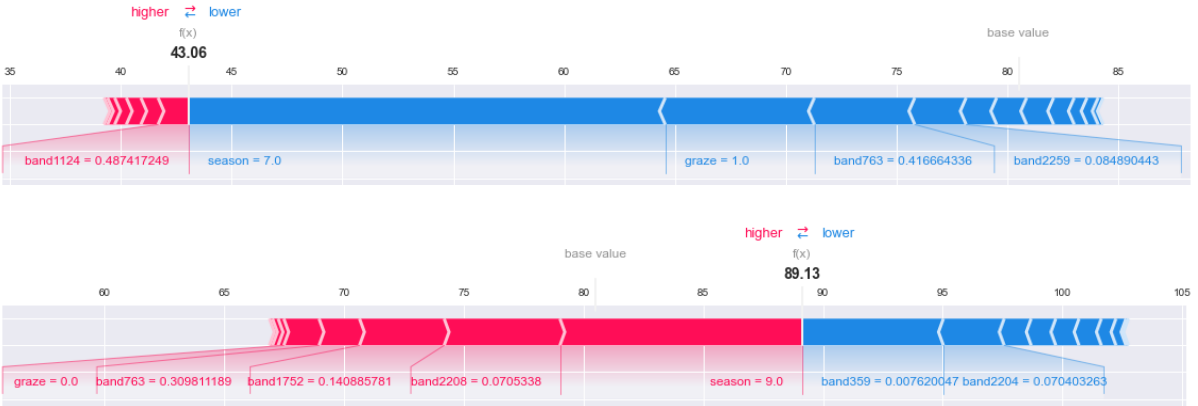
Figure 17. AGB inversion data processing process. The top chart shows article 40 data and the bottom chart shows article 800 data.